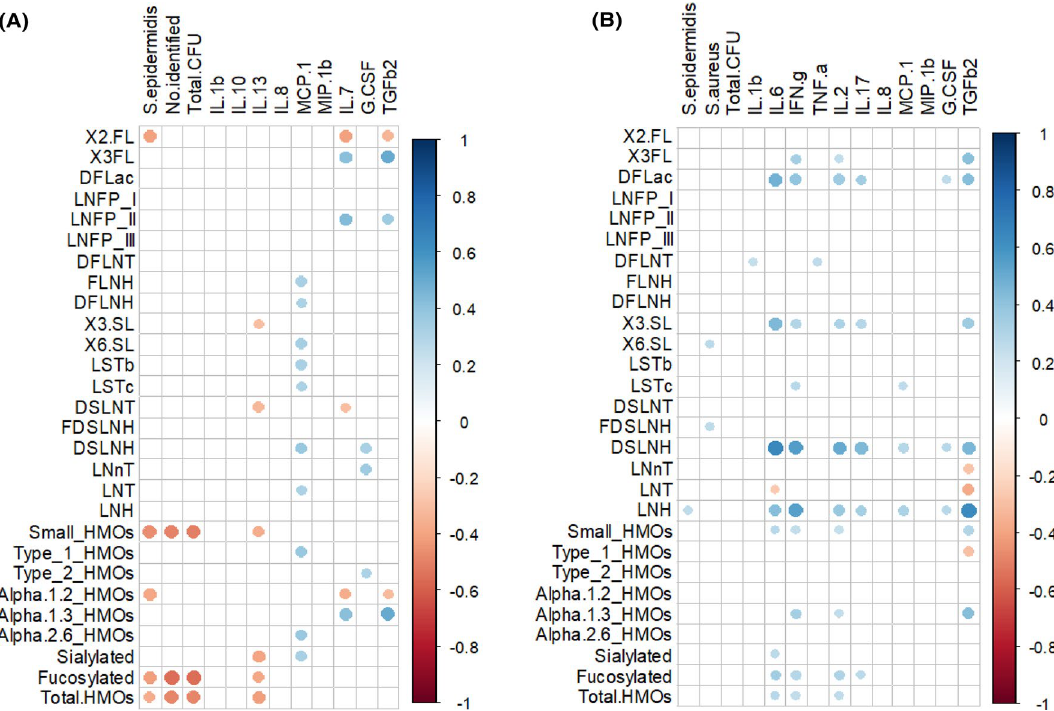
Figure 3. Spearman rank correlations between individual and grouped HMOs, microbial counts and immunological compounds concentrations in milk samples from healthy women (HW group; A ) and mastitis cases (MW group; B ). Only statistically significant ( p < 0.05) correlations between those individual or grouped compounds or bacteria that were present in > 50% of the samples in each group are shown. The strength and colors indicate directionally (blue denotes positive; red denotes negative) of the association. DFLac, difucosyllactose; DFLNH, difucosyllacto- N -hexaose; DFLNT, difucosyllacto- N -tetrose; DSLNH, diasilyllacto- N -hexaose; DSLNT, diasilyllacto- N -tetraose; FDSLNH, fucodisialyllacto- N -hexaose; FLNH, fucosyllacto- N -hexaose; HMO, human milk oligosaccharide; LNFP, lacto- N -fucopentaose; LNH, lacto- N - hexaose; LNnT, lacto- N -neotetraose; LNT, lacto- N -tetraose; LSTb, sialyl-lacto- N -tetraose b; LSTc, sialyl-lacto- N -tetraose c; 2’FL, 2’-fucosyllactose; 3FL, 3-fucosyllactose; 3’SL, 3’-sialyllactose; 6’SL, 6’-sialyllactose. Total HMO-bound sialic acid; total HMO-bound fucose; small HMO; type 1; type 2; α-1,2; α-1,3; and α-2,6 were calculated as the sum of all sialic acid moieties bound to each HMO; all fucose moieties bound to each HMO; 2’FL + 3FL + 3’SL + 6’SL; LNT + LNFP I + LNFP II + LSTb + DSLNT; LNnT + LNFP III + LSTc; LNFP I + 2’FL; LNFP III + 3FL; and LSTb + LSTc + 6’SL, respectively. GCSF, granulocyte colony-stimulating factor;